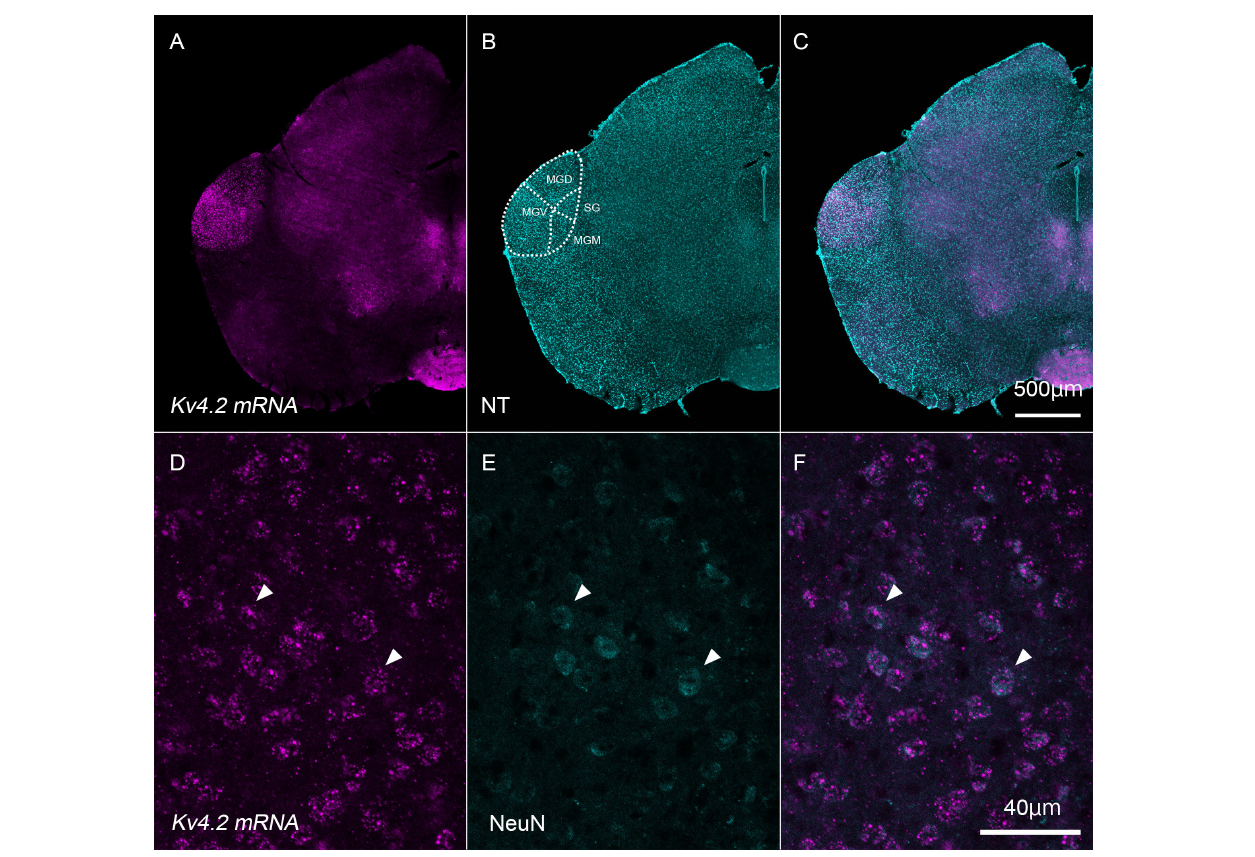
FIGURE 1 | Kv4.2 mRNA expression in neurons that have their cell bodies in the medial geniculate body. (A–C) Double fluorescence staining for Kv4.2 using in situ hybridization ( Kv4.2 mRNA, magenta) and NeuroTrace 435/455 (NT, cyan) labeling in the adult mice brainstem coronal section, including the dorsal medial geniculate (MGD) and ventral medial geniculate (MGV). (D–F) Kv4.2 subcellular localization in the MGV. High magnification of the MGB images showing double fluorescence staining of Kv4.2 using in situ hybridization ( Kv4.2 mRNA, magenta: D ), immunostaining of NeuN (cyan: E ), and merged (F) images. Scale bars: 500 µ m (A–C) and 40 µ m (D–F) . Kv4, Shal-related subfamily of potassium voltage-gated channel; MGB, medial geniculate body; MGD, dorsal MGB; MGM, medial MGB; MGV, ventral MGB; NT, NeuroTrace; NeuN, neuronal nuclei; SG, suprageniculate